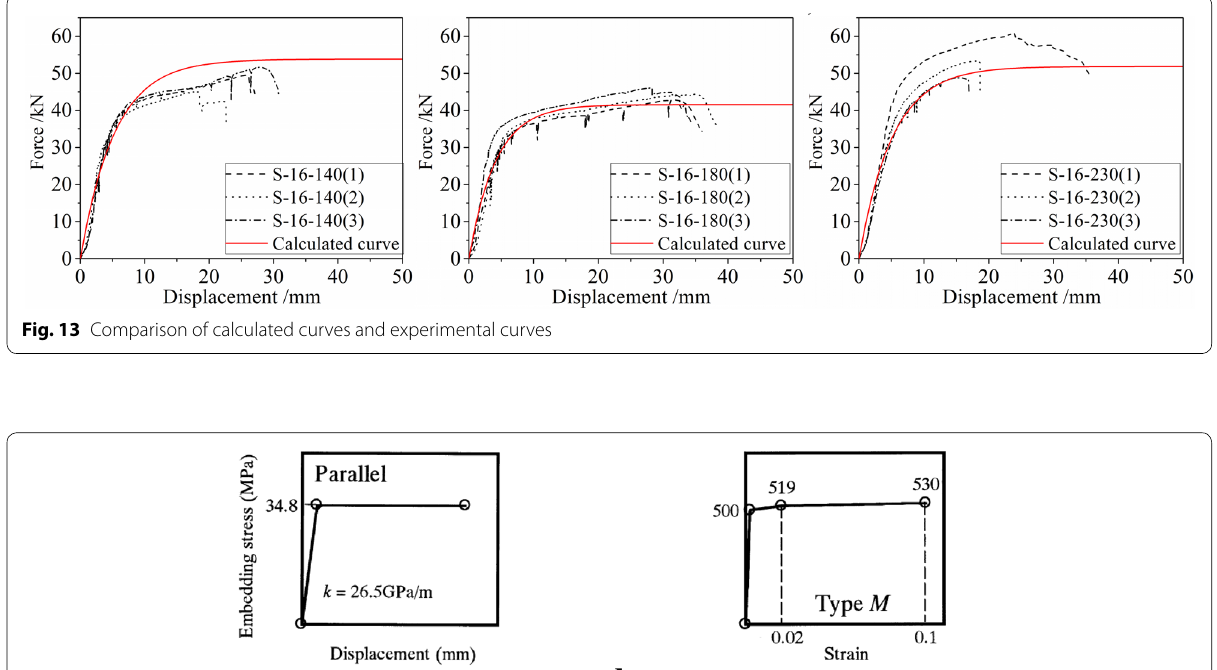
Fig. 14 Material properties from the literature [6]